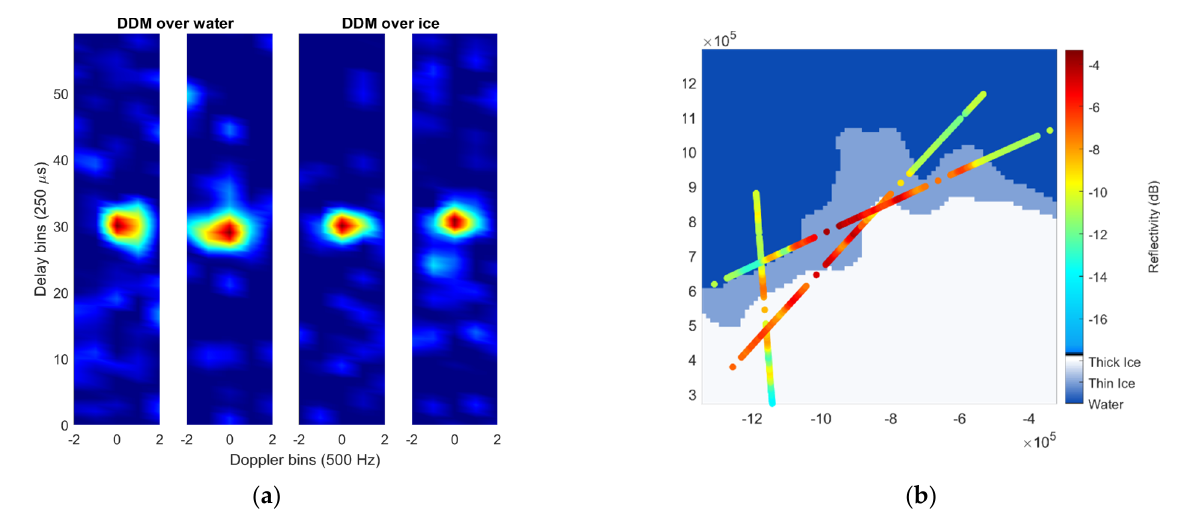
Figure 2. FMPL-2 GNSS-R data: ( a ) DDM over water and ice comparison; and ( b ) Reflectivity tracks over the OSI SAF map.